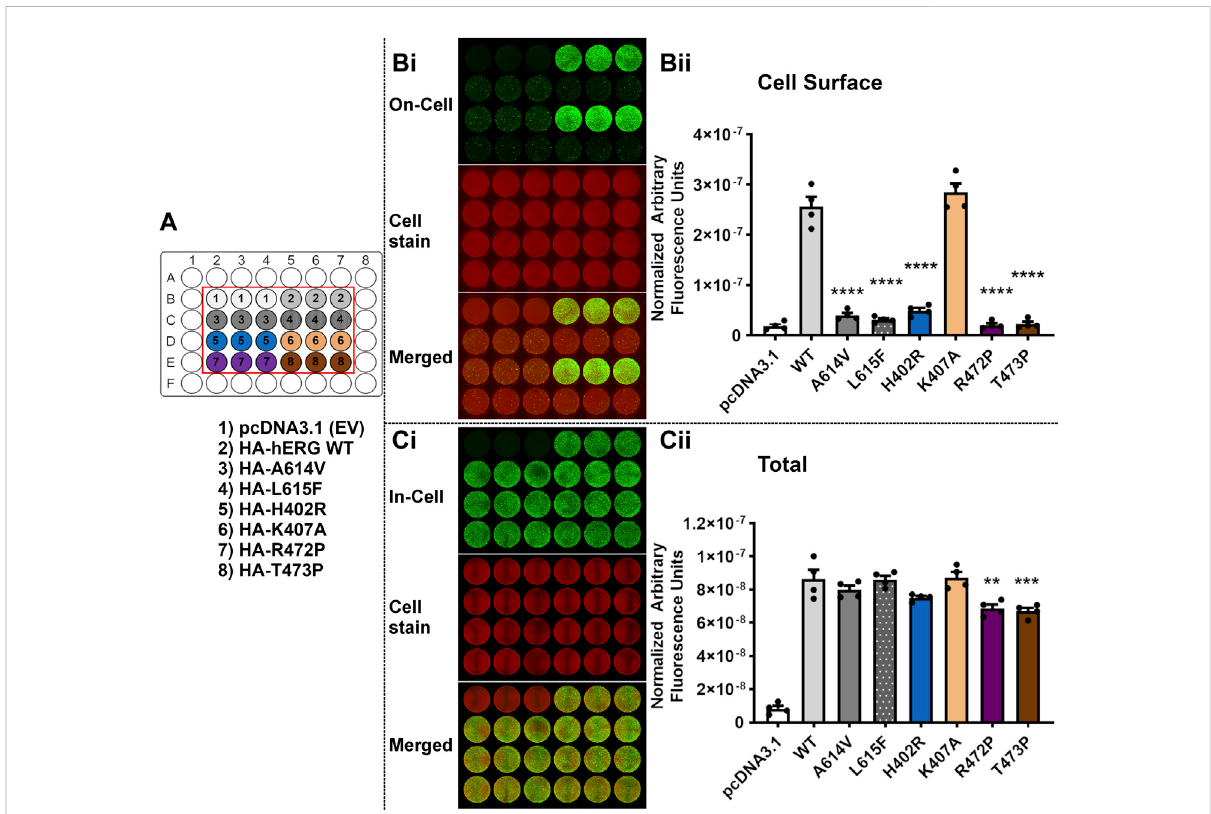
Figure5.Dataarepresentedas(mean±SEM)fromfourindependentrepeats[individualdatapointsaredisplayedin (Bii,Cii) ].Statisticalanalyseswere performed using one way analysis of variance (ANOVA) and Bonferroni ’ s multiple comparison. Asterisks indicate a signi fi cant difference from the corresponding WT value (**** = p < 0.0001; *** = p < 0.001; ** = p <